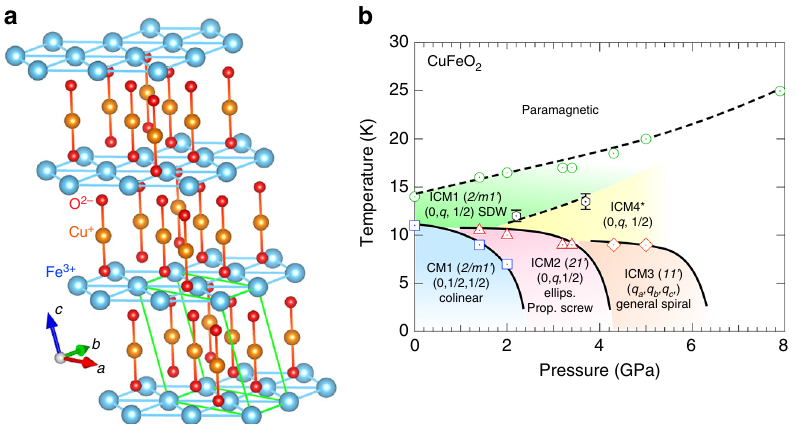
Fig. 1 Crystal structure and magnetic and dielectric phase diagram as functions of temperature and pressure. a The crystal structure of delafossite CuFeO 2 , showing low-temperature monoclinic unit vectors. b A pressure versus temperature magnetic phase diagram for CuFeO 2 . Circle, squire, triangle, and diamond symbols were taken from the previous paper 17 . The phase transition points shown by hexagon symbols have been de fi ned in the present work. The solid and dotted lines denote fi rst and second order phase transitions, respectively. In the present experiment, it has not been clear that the ICM4 phase either exists as a single phase or coexists with ICM1 phase. Details are described in the main Figure 2. A ⊥ and B ⊥ are spin projection vectors along the major and minor axes on the plane perpendicular to the scattering vector, respectively. D is the volume faction of the spin helicity domains, D = | V RH − V LH |/| V RH + V LH |, where V RH ( V LH ) is volume of the right(left)-handed domain. Therefore, P xx is always fl ect the helicity − 1 for a magnetic re fl ection. P yx and P zx re domains ratio, and P yy ( = − P zz ) and P yz ( = P zy ) re fl ect the magnetic structure shape projected to the plane perpendicular to the scattering vector.